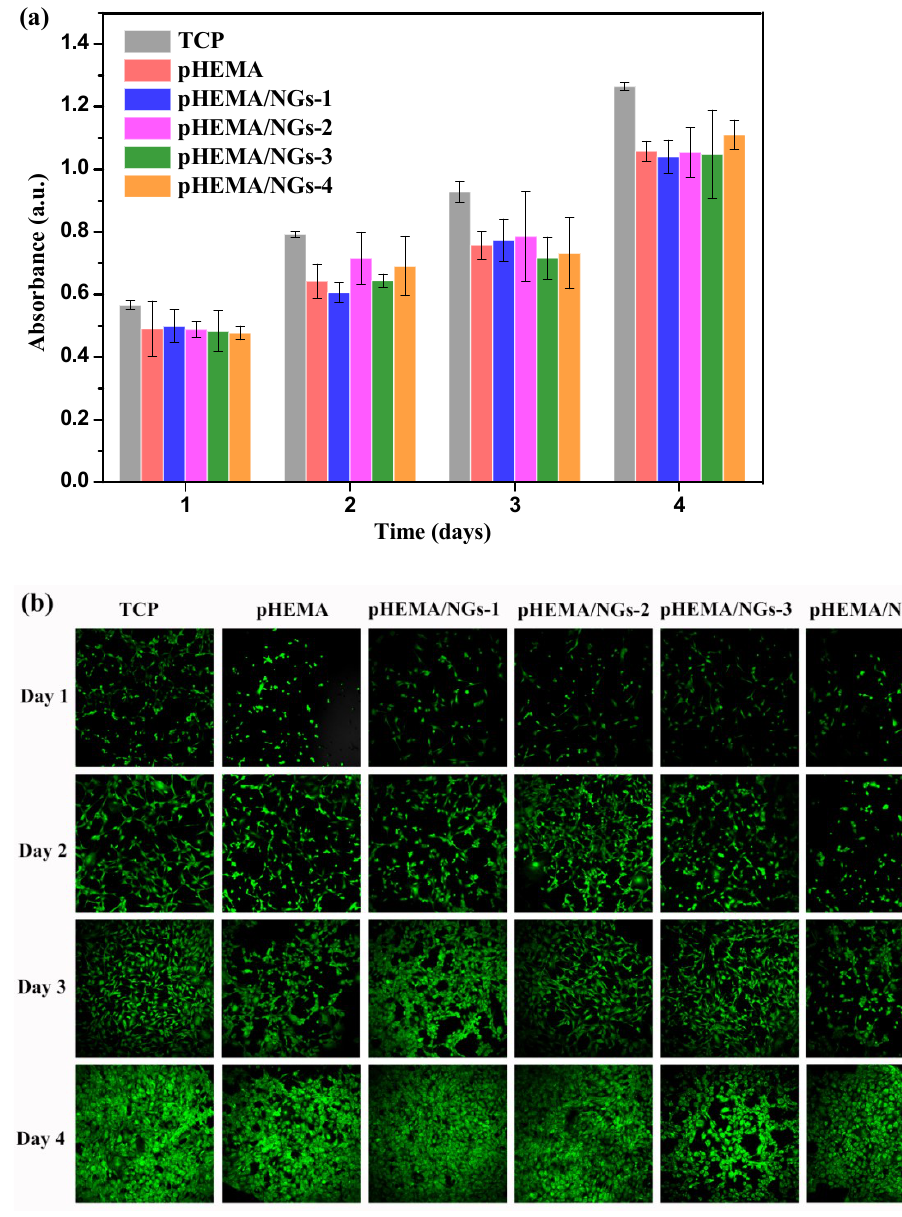
Figure 10. Cytocompatibility test for the series of contact lenses. ( a ) OD values of viable 3T3 cells by CCk-8 assays; error bars represent mean ±SD ( n = 5). ( b ) Confocal fluorescence images of Calcein AM (green)-stained 3T3 cells incubated on tissue culture plate (TCP) and on the series of contact lenses from day 1 to day 4. The scale bar is 200 μm.